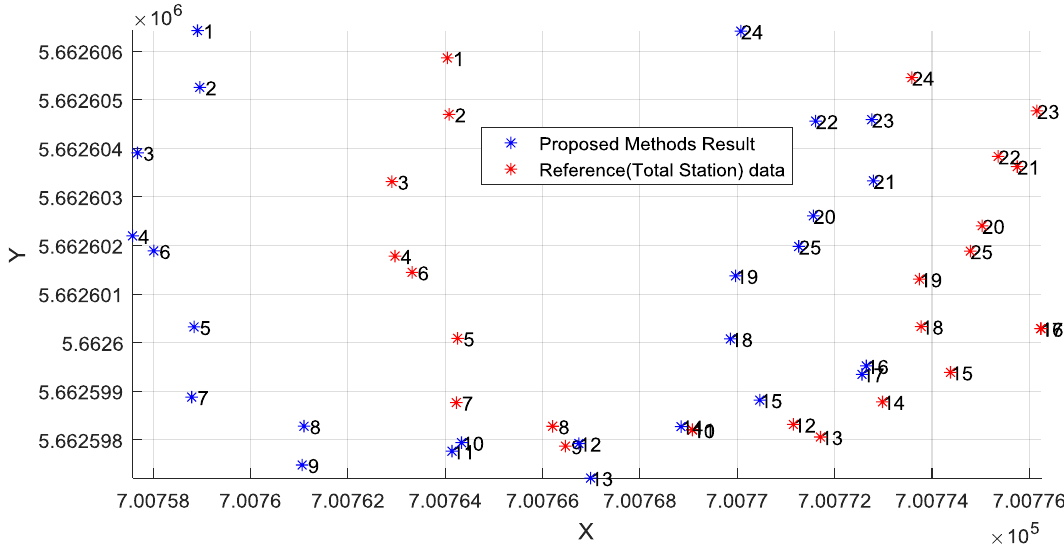
Figure15. Estimated horizontal coordinate of tie point.